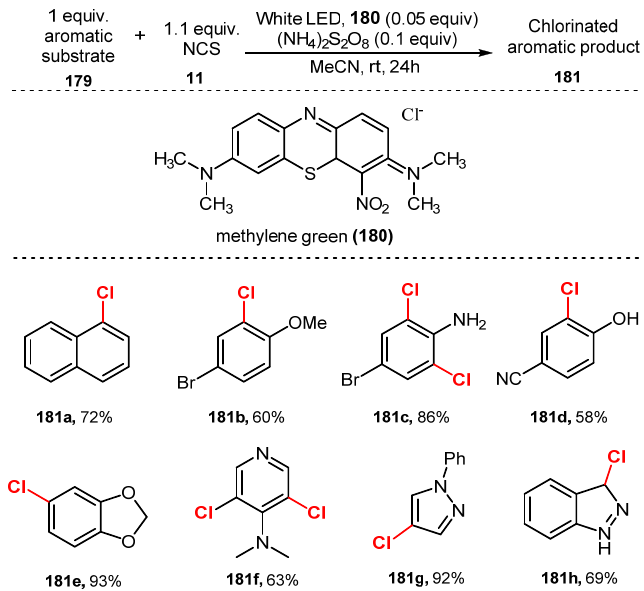
Scheme 49. Chlorination of arenes and heteroarenes via organic dyes. A plausible reaction mechanism was proposed as shown in Scheme 50. Irradiation of light allowed methylene green to transfer from ground state methylene green 180 to excited state methylene green 182 . Then, 182 led to the single-electron oxidation of NCS 11 , giving cationic radical 184 and providing reduced state methylene green 183 . The radical 184 reacted with substrate 179 to generate arene chloride cation intermediate 186 and charged succinimide 185 . Capture of a proton from intermediate 186 by anion 187 yielded final product 181 . In addition, the reduced state methylene green 183 was oxidized to give back ground state methylene green 180 and to provide succinimide anion 187 by other oxidants (for example ammonium peroxodisulfate or oxygen gas in air) or by charged succinimide 185 .